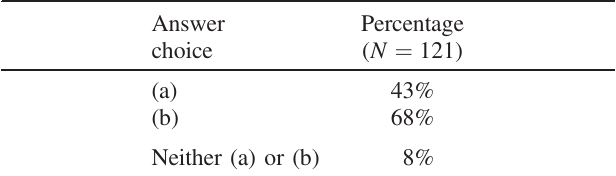
TABLE III. Percentage of each answer chose by students on task 3. Students were allowed to choose more than one